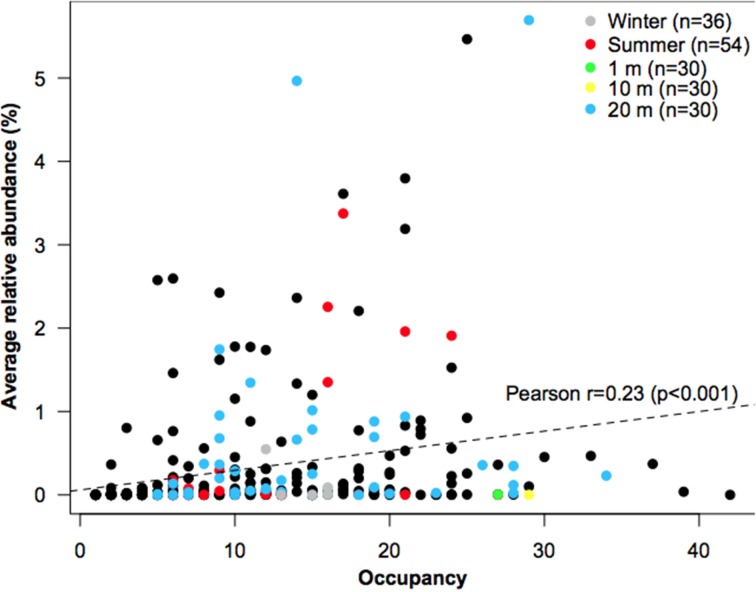
Average relative abundance (y-axis) and occupancy (x-axis) of all OTUs. Colored dots represent top indicator OTUs for each environment, with indicator values >0.3 and P < 0.01. The number of samples for each environment is denoted in the legend.